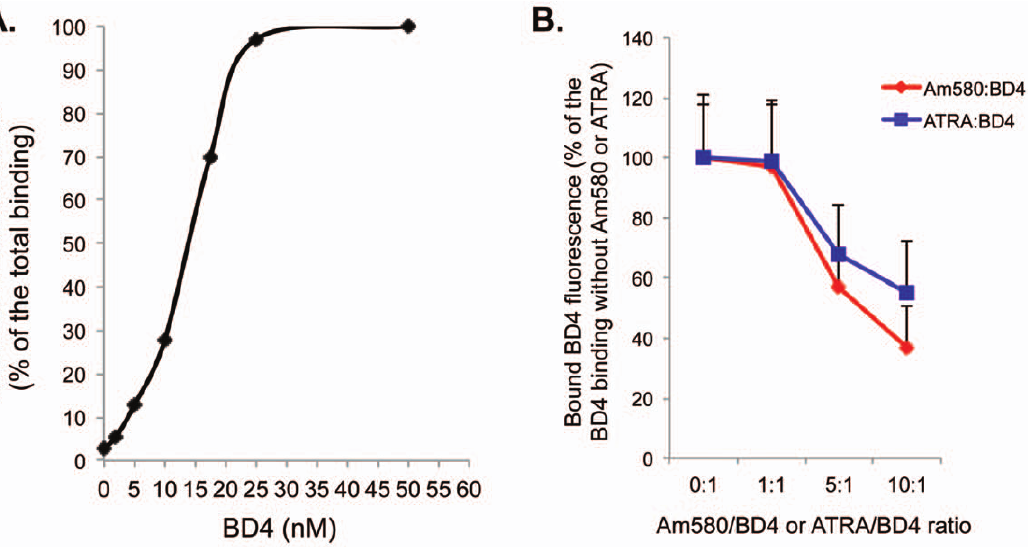
Figure 3. RAR a binding assay. A fluorometric binding assay was performed as described in the method. A. The scatter curve was built between different concentrations of BD4 and percentage BD4 binding to calculate the KD. A representative curve is shown from four independent experiments. KD=14 6 5 nM, n=4. B. Competitive binding assays were performed between BD4 and Am580 or BD4 and ATRA. No significant inhibition of binding was observed at 1:1 ratio. However, a 40% inhibition of BD4 binding was observed when Am580 to BD4 or ATRA to BD4 ratio was increased to 5:1. These data suggest that the affinity of BD4 binding to RAR a is higher than Am580 and ATRA.